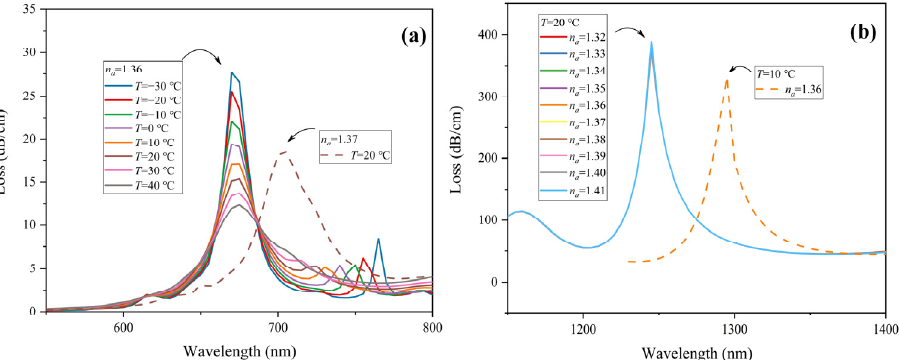
Figure 7. ( a ) CL spectrum of y -polarization core mode in RI sensing channel under different ambient temperatures T from − 30 to 40 °C when n a = 1.36 (solid line) and under T = 20 °C when n a = 1.37 (dotted line). ( b ) CL spectrum of x -polarization core mode in temperature sensing channel for various n a from 1.32–1.41 at T = 20 °C (solid line) and under T = 10 °C when n a = 1.36 (dotted line).